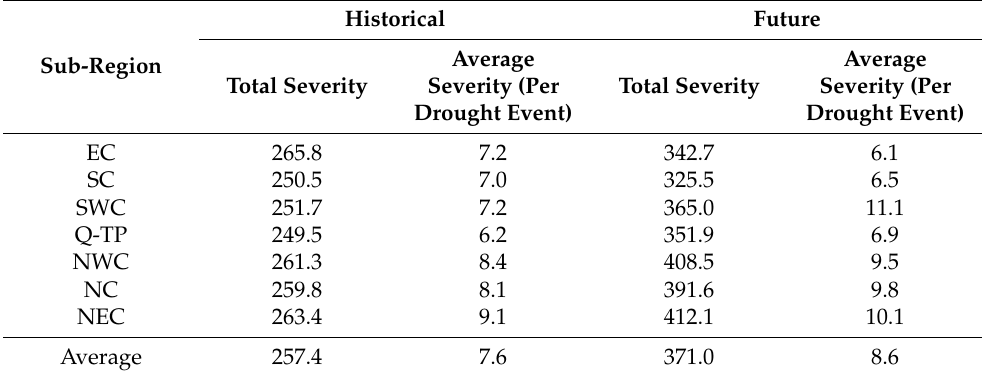
Table 7. Drought severity in each sub-region during the historical period (1961–2020) and the future period